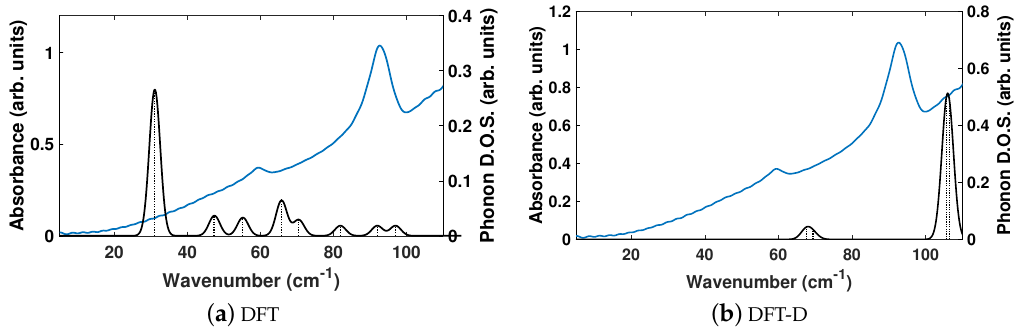
Figure 2. Comparisons of the computed phonon modes (black solid curves) to experimentally obtained THz spectra (solid blue curves) of BPE using ( a ) DFT and ( b ) DFT-D. Dashed black vertical lines are the normalized phonon mode intensity used to obtain the phonon density of states (DOS). All measurements are given in arbitrary